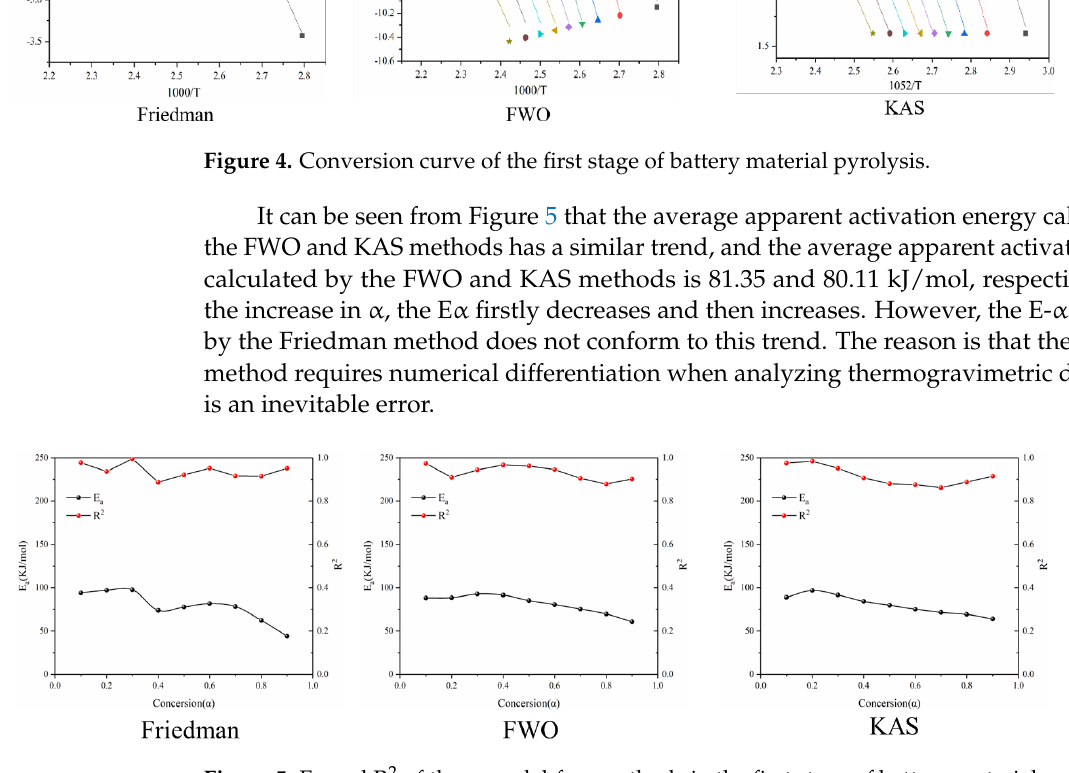
Figure 5. Ea and R 2 of three model-free methods in the first stage of battery material pyrolysis.